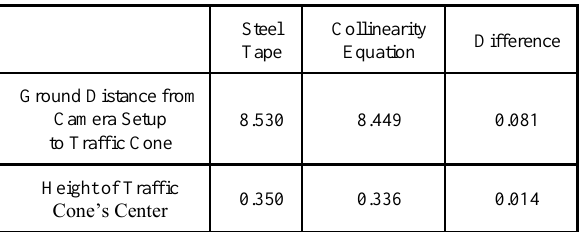
Table 3. The Computed Position of the Traffic Cone in